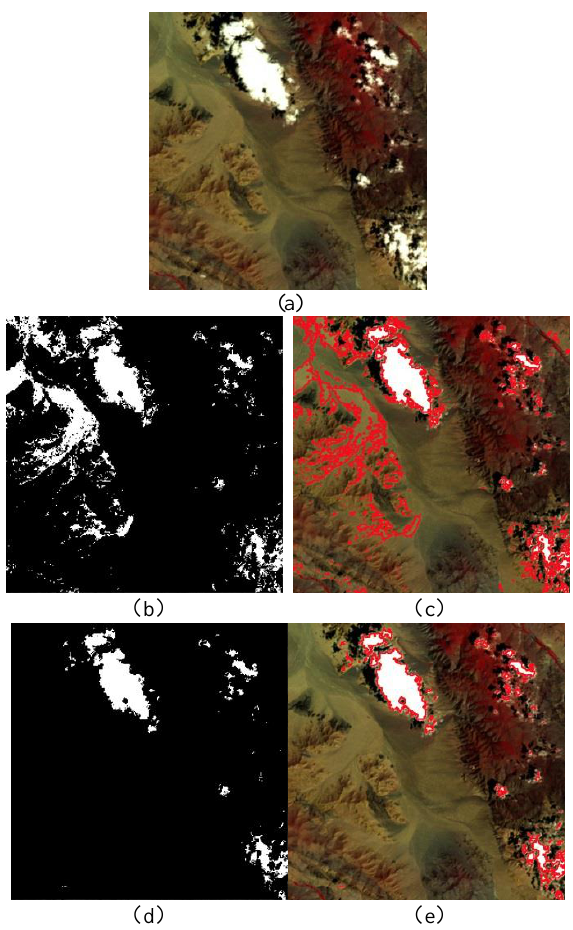
Figure 13. Procedure of proposed cloud detection algorithm.